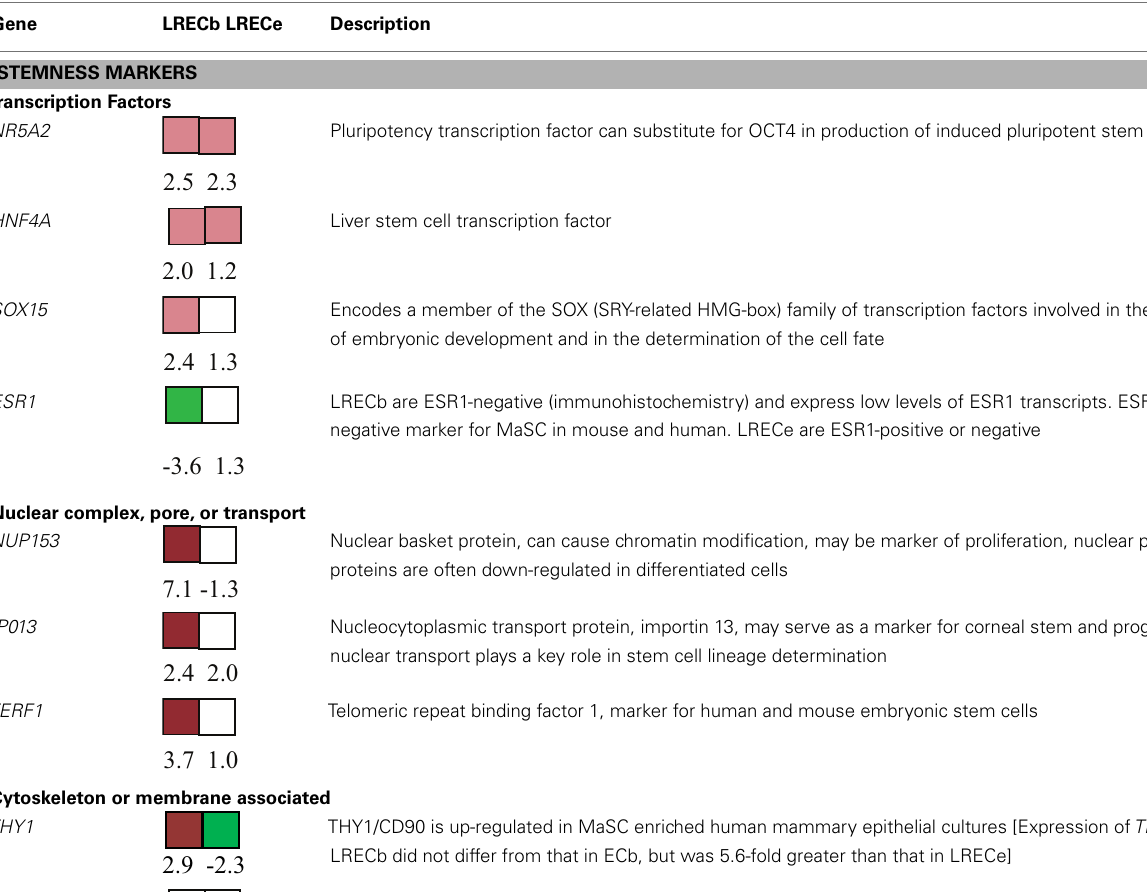
Table 1 |Attributes of LREC in prepubertal bovine mammary epithelium 1